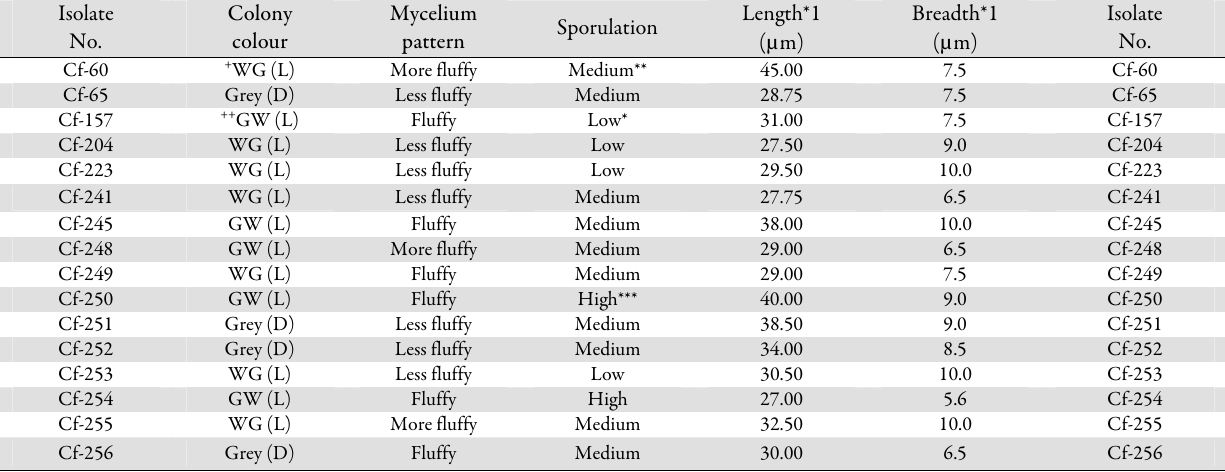
Tab. 2. Colony characters of different isolates of Colletotrichum